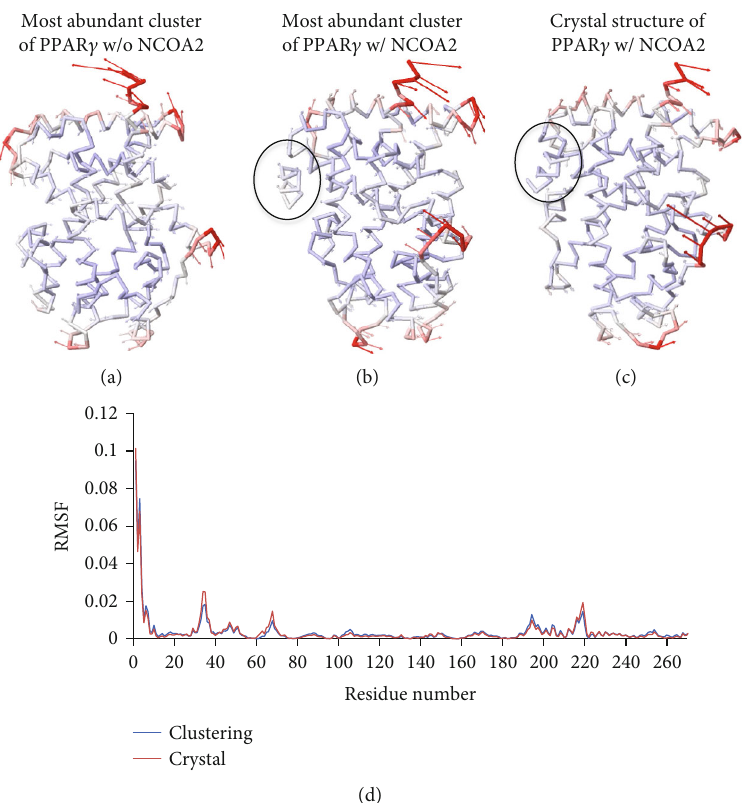
Figure 15: Anisotropic network models of our most abundant cluster of PPAR γ (a), our most abundant cluster of PPAR γ with nuclear receptor coactivator 2 (NCOA2) peptide docked (b), and the PPAR γ -NCOA2 complex from the original crystal structure (PDB ID: 3DZY) (c), plus an RMSF plot (d) comparing the fl uctuations of the PPAR γ -NCOA2 complex derived from docking NCOA2 into our most abundant cluster of PPAR γ (b; blue) to the original crystal structure of the PPAR γ -NCOA2 complex (c;